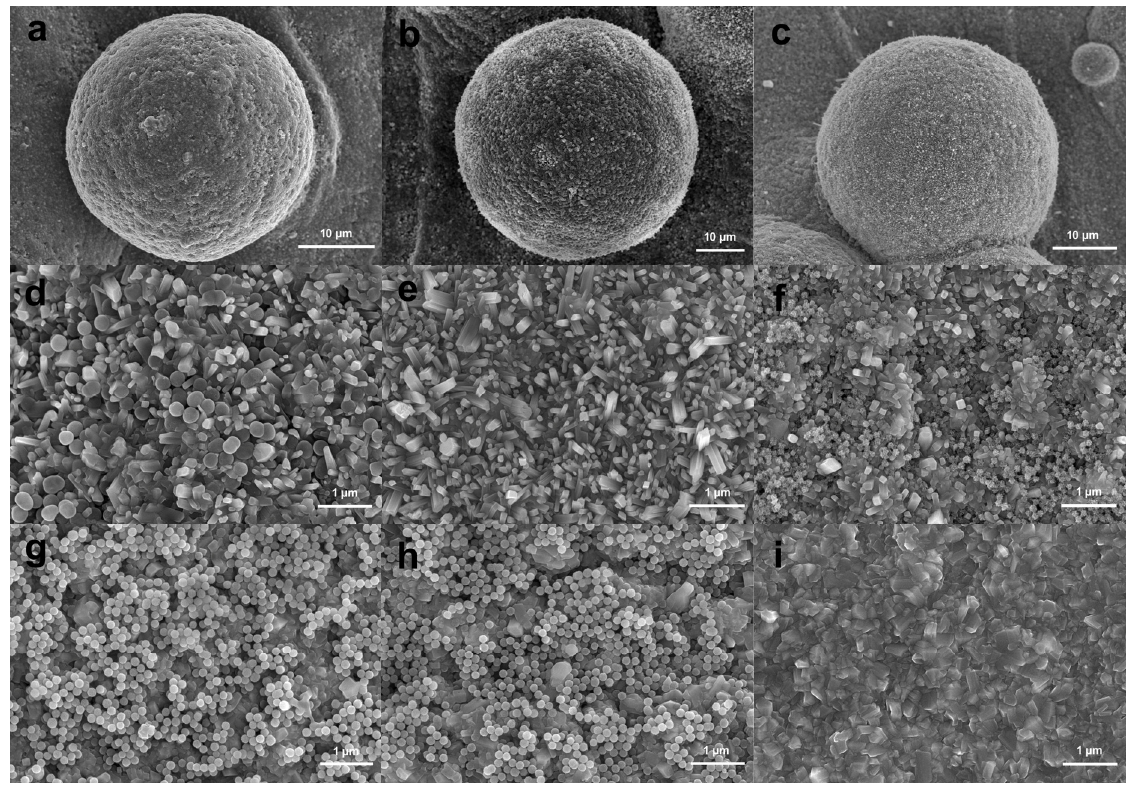
Figure 5. SEM surface morphology of MBG-SLM-Ti ( a – f ) and MBG-CP-Ti ( g – i ) after immersion in SBF for 1 ( a , d , g ), 3 ( b , e , h ) and 7 ( c , e , i ) days.